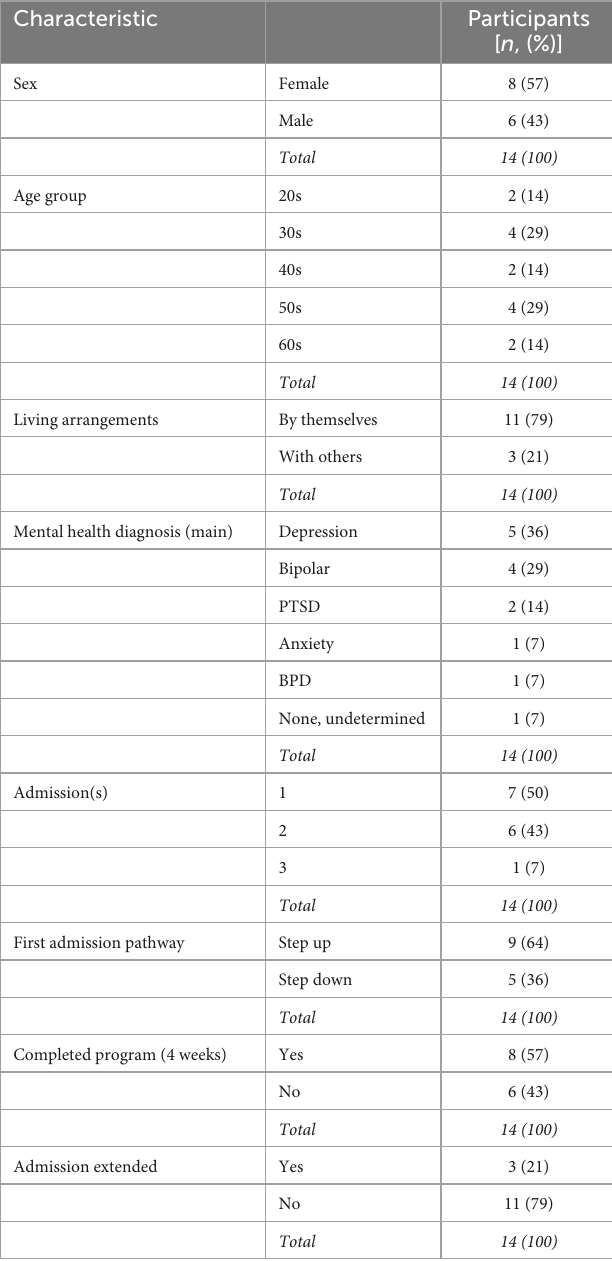
TABLE 3 Sample characteristics—demographics and self-reported clinical and service use data ( n = 14).